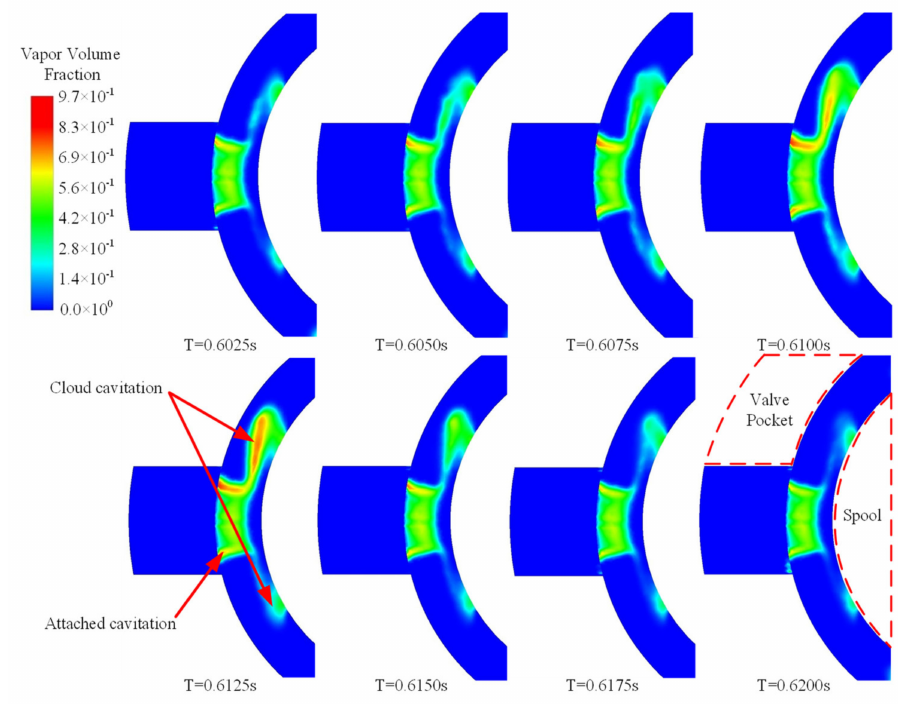
Figure 9. Morphological variation of cavitation on the convex shoulder surface with nearby openings.